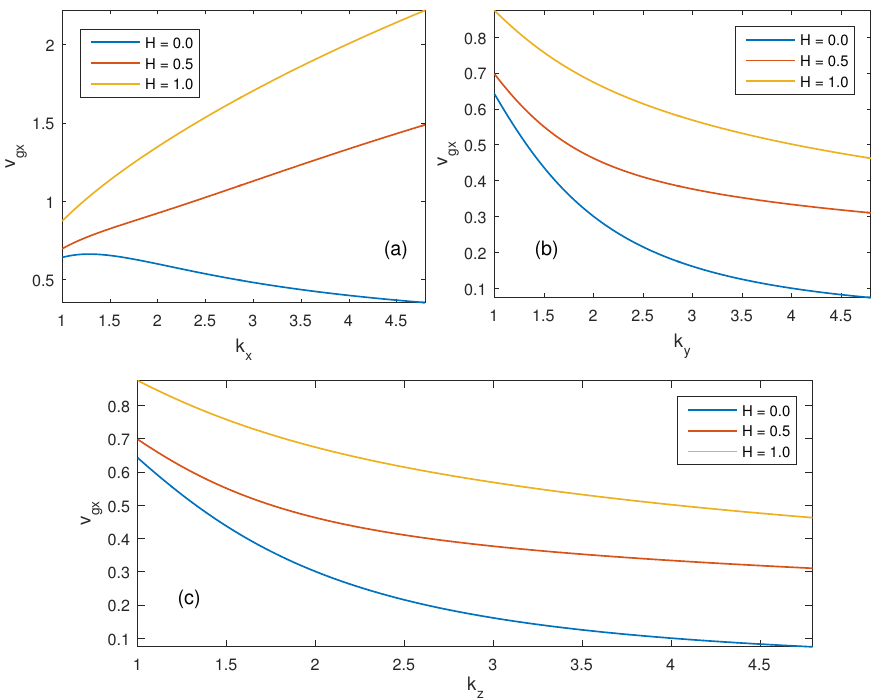
Figure 4. The plot of the x-component of group velocity ( v gx